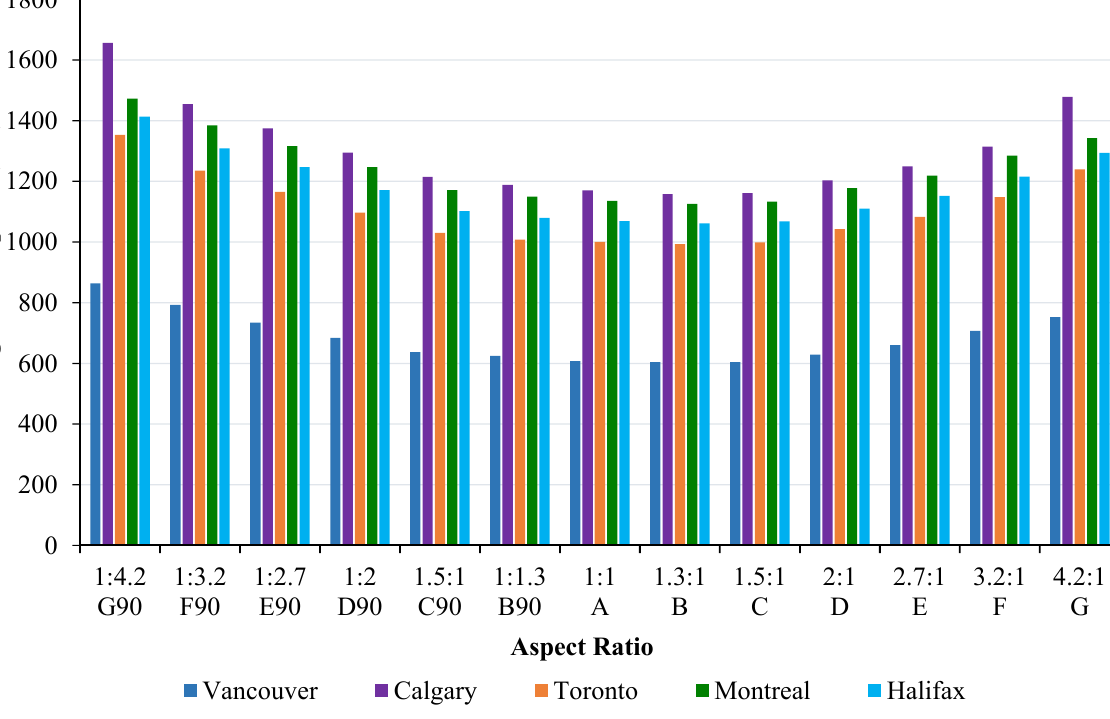
Figure 12. Annual heating consumption for aspect ratios in Canadian